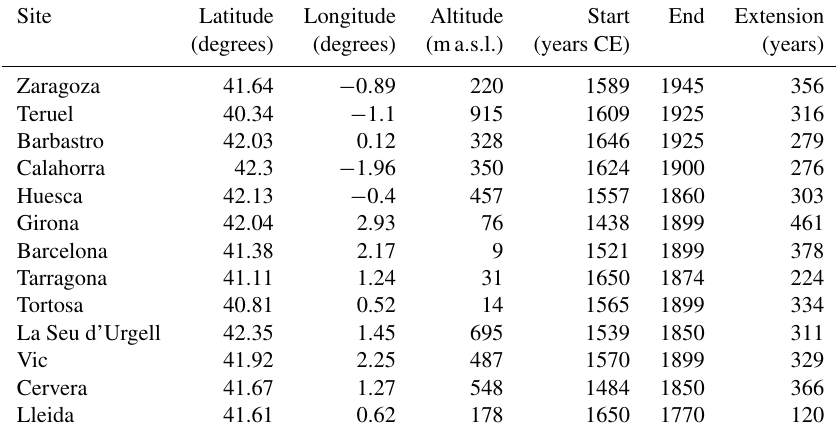
Table 1. Historical document characteristics in the northeast of